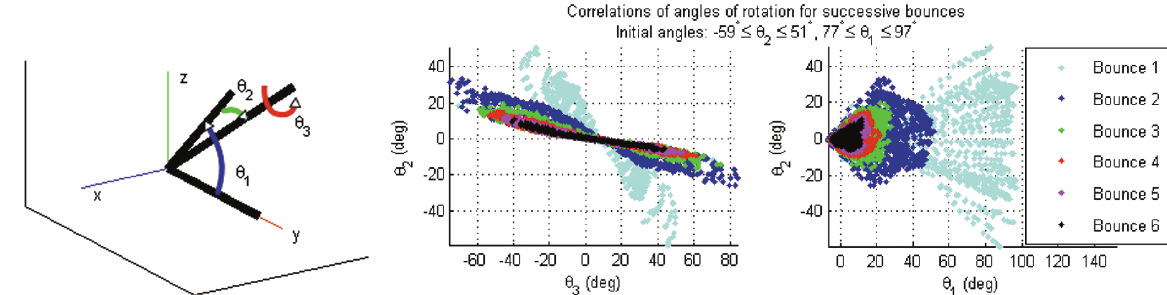
Fig. 9. The free end rotation is measured by Fig. 10. Regular, significant motion was observed in the deployment angles as shown for deploy- a deployment angle, θ 1 ; a side angle, θ 2 ; ments of ≈ 90 ○ and side angles up to 60 ○ . Translation was not significant, being uncorrelated and and a twist angle, θ 3 . typically less than 3% of the nominal